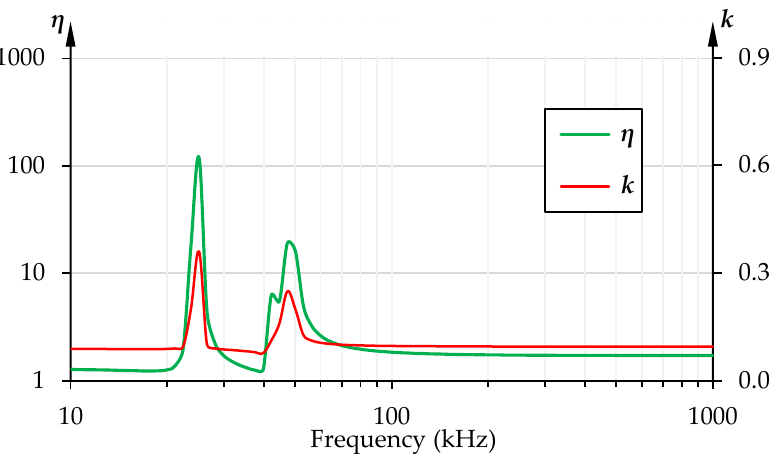
Figure 12. Frequency response of the magnetic meta-hose with the highest magnetic field ratio k ( ν = 0.45, µ m = 26) identified at f r = 25 kHz.